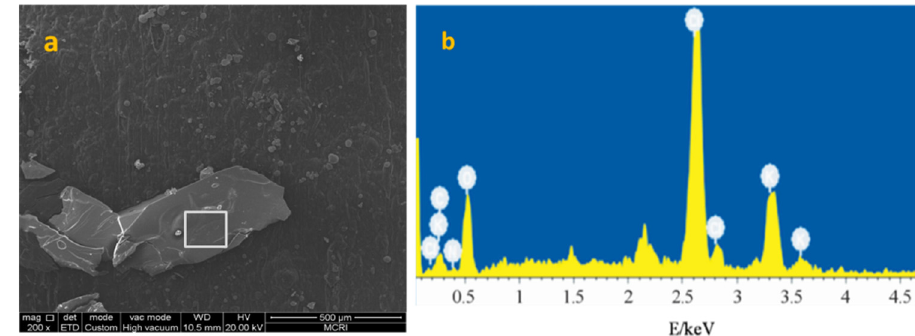
Figure 10: FESEM image ( a ) and EDS pattern ( b ) of crystalline fl akes on the surface of GaTo aged at 75°C for 22